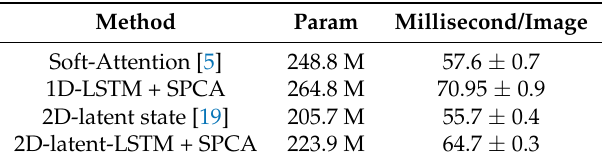
Table 1. The parameters and speed results on Structure Preserving Convolutional Attention (SPCA). Speed results based on beam size 3, batch size 20 on an NVIDIA Titan X GPU.